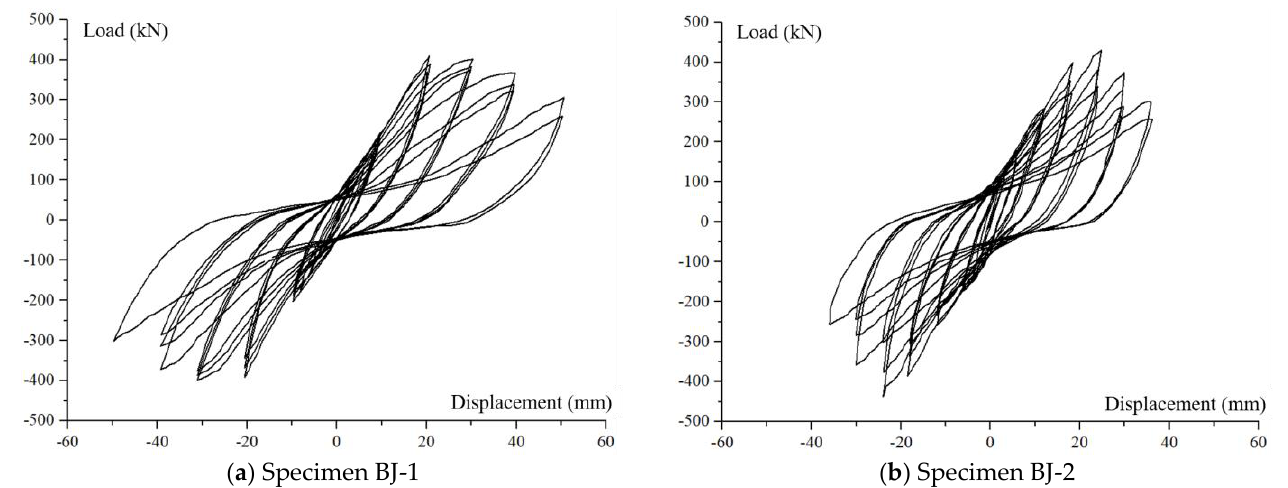
Figure 18. Hysteretic curves of cruciform joints.